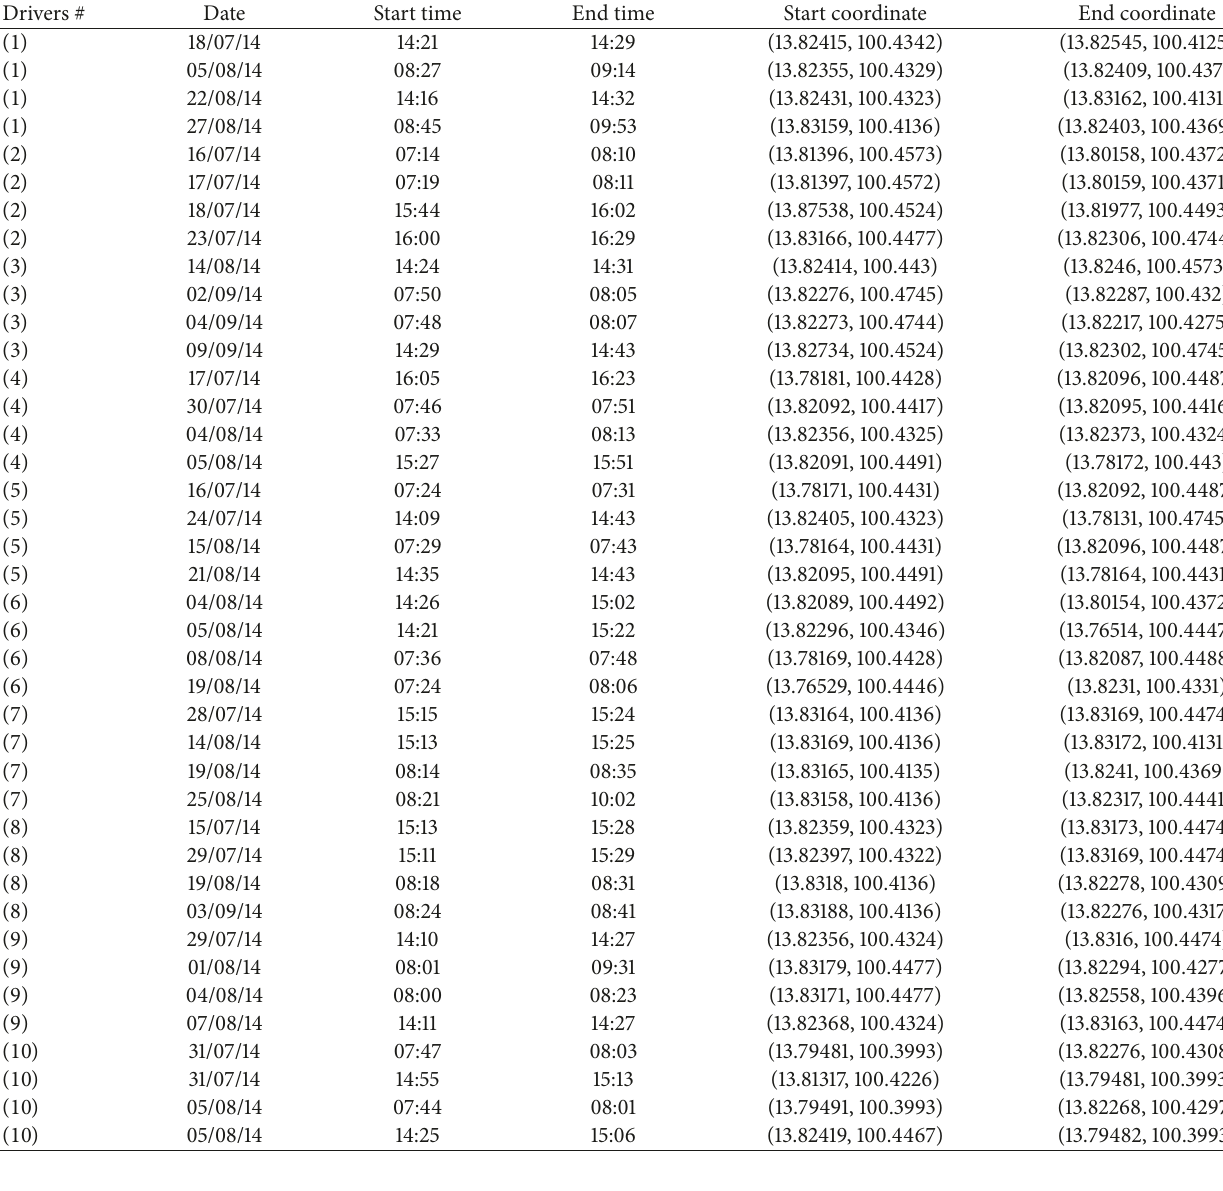
Table 1: This table shows the information of 40 trips which are used in the algorithm performance evaluation. Drivers #